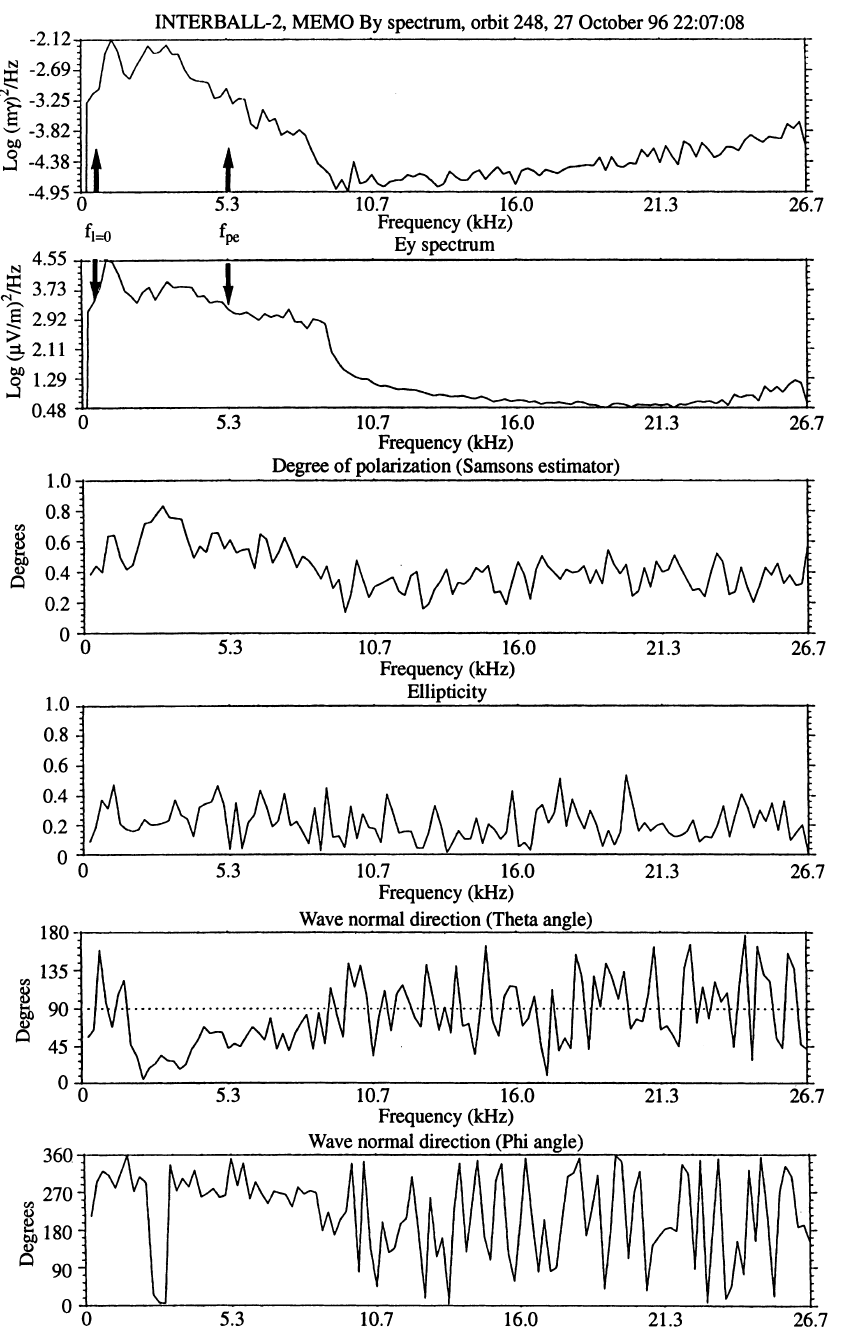
Fig. 5. Wave analysis over a 0.1 s time interval of the auroral hiss of Fig. 4. The time interval is centered around 22:07:08 UT. From top to bottom are represented: the auto-power spectrum of the Bx